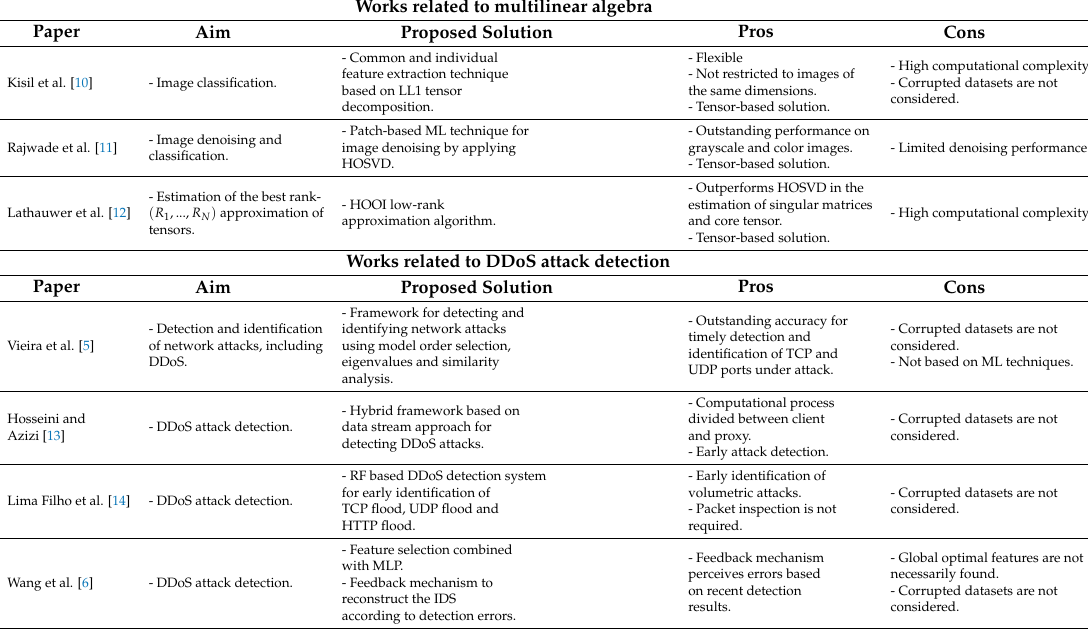
Table 1. Related